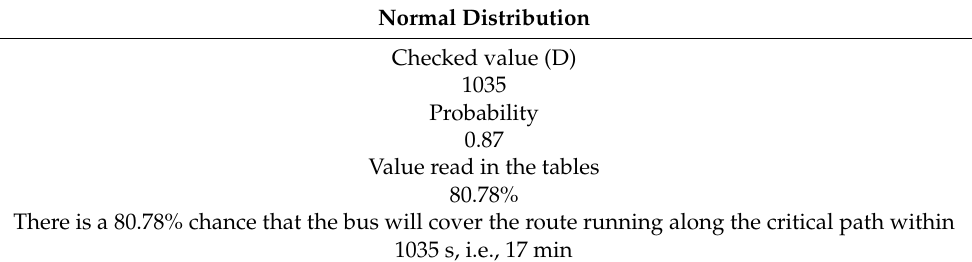
Table 3. Stage 7—Computing the probability of covering the route in the stipulated